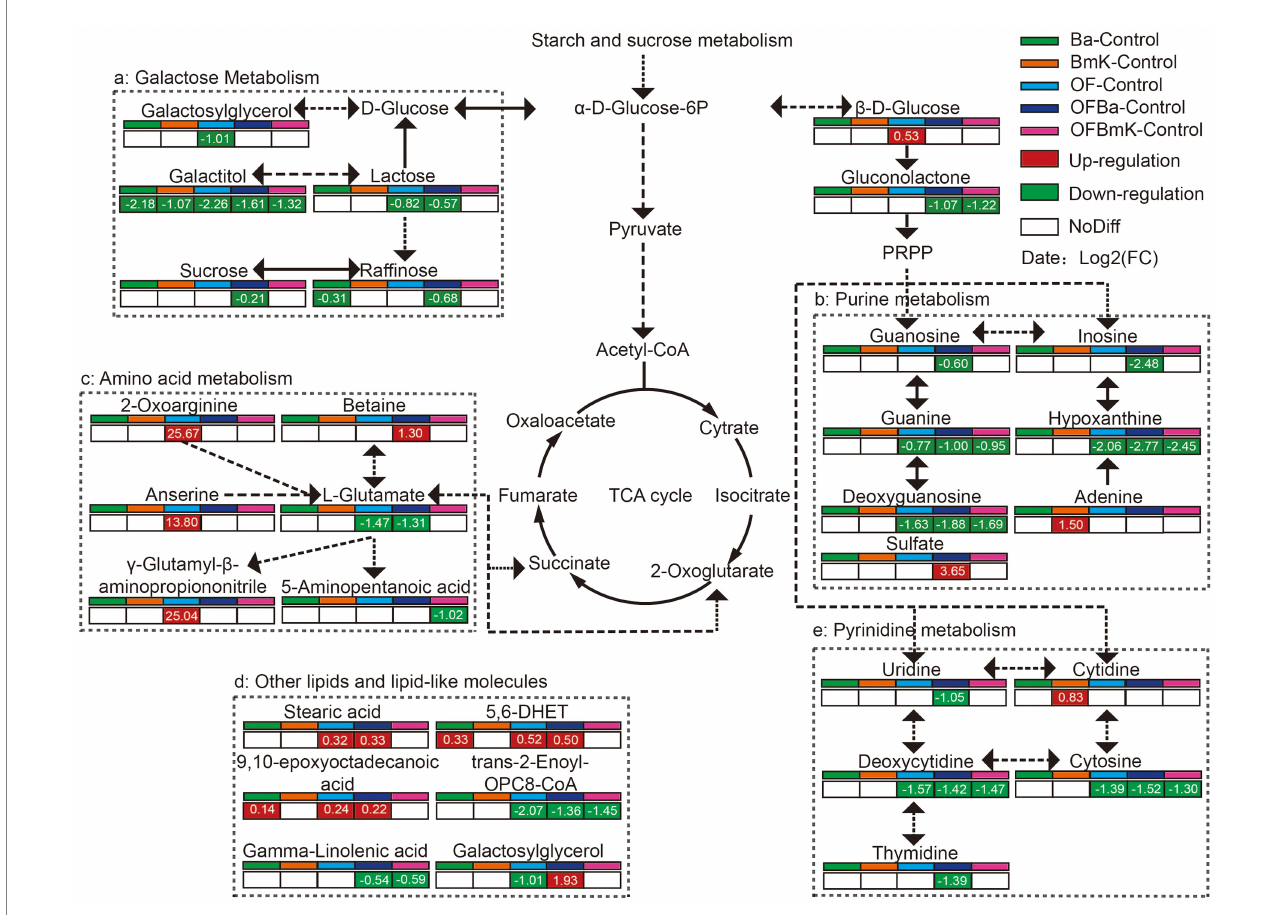
FIGURE 7 The soil primary metabolic network of the carbohydrate, amino acid, purine, and pyrimidine metabolic pathways after